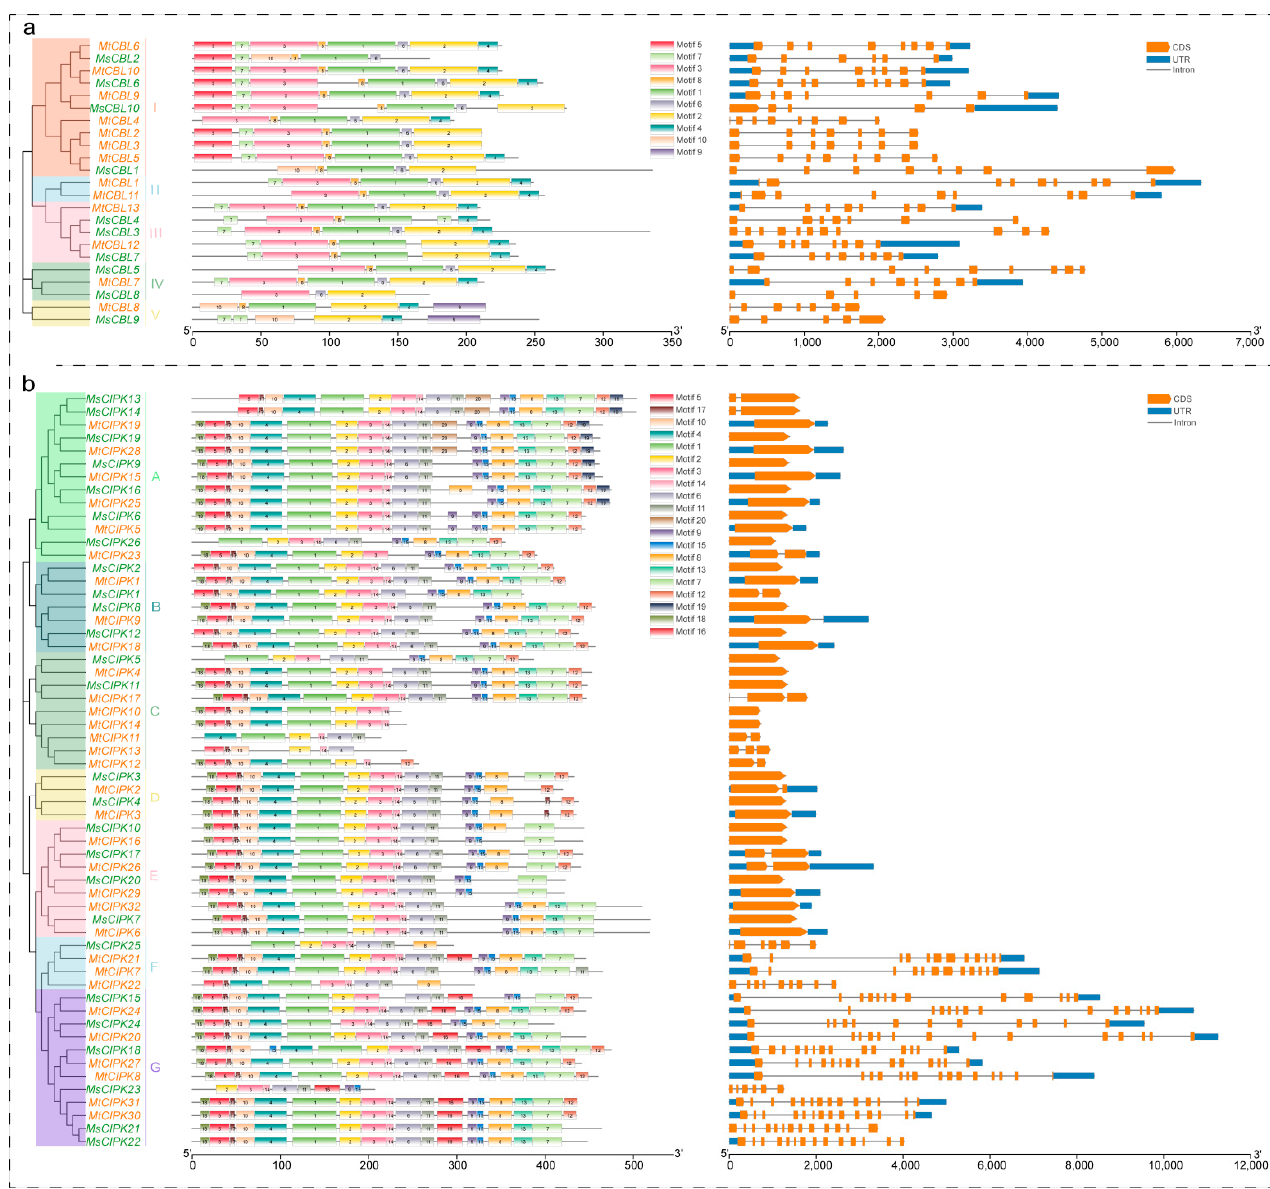
Figure 2. Analyses on phylogenetic relationships, motifs, and gene structure of CBL and CIPK genes from M. sativa and M. truncatula . The groups and its color of the phylogenetic tree are consistent with those in Figure 1. The motifs were indicated in different colored boxes with different numbers and the sequence information for each motif is provided in Figure S1-2. Exon–intron structure and conserved domain of CBL and CIPK genes. Blue boxes indicate 5 ′ - and 3 ′ - untranslated regions; orange boxes indicate exons; black lines indicate introns. ( a , b ) Phylogenetic relationships, motifs, and gene structure of CBL genes ( a ) and CIPK genes ( b ).